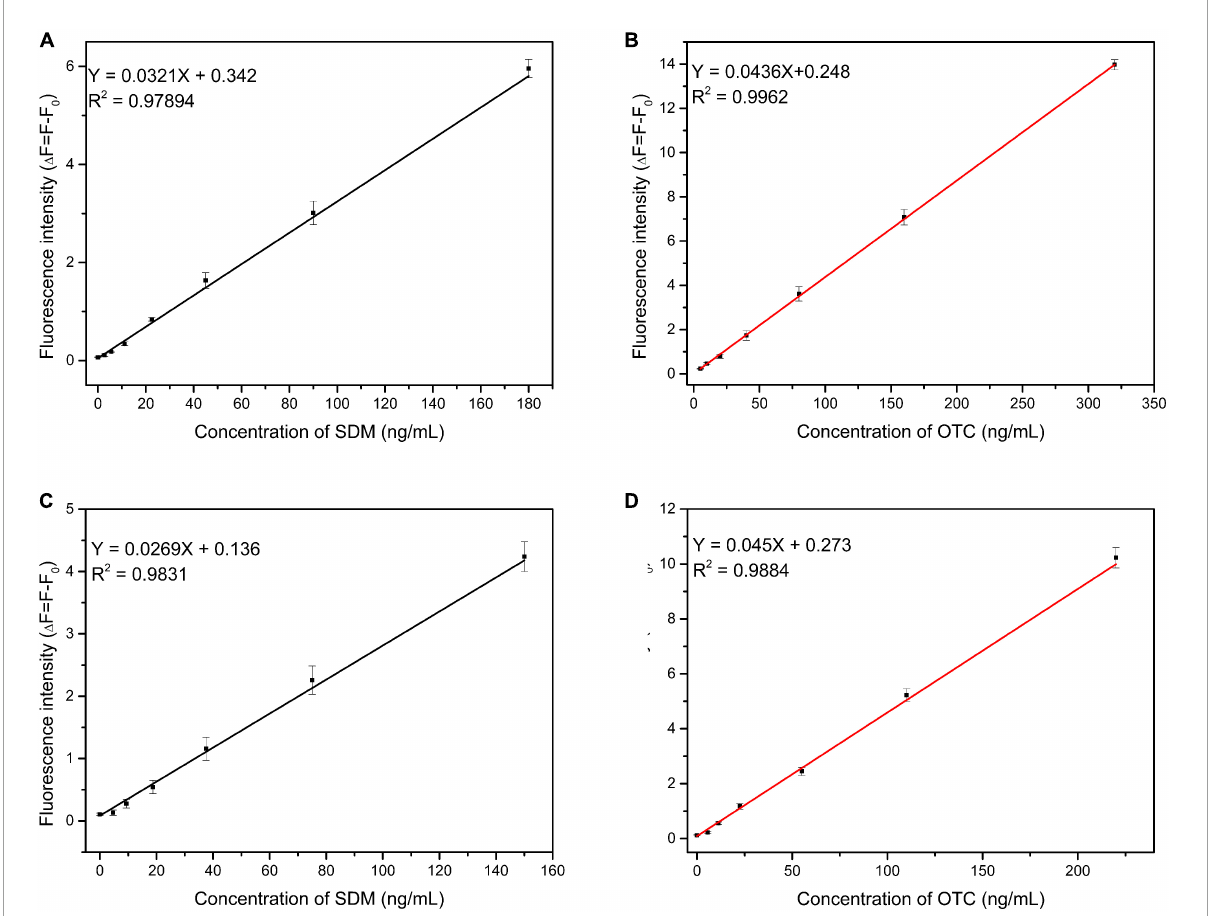
FIGURE5 Linearity between fluorescence intensity and target concentration. (A,B) : Two types of aptamers were added separately; (C,D) : two types of aptamers were added together. (The concentrations of sulfadimethoxine (SDM) and oxytetracycline (OTC) were set at 100